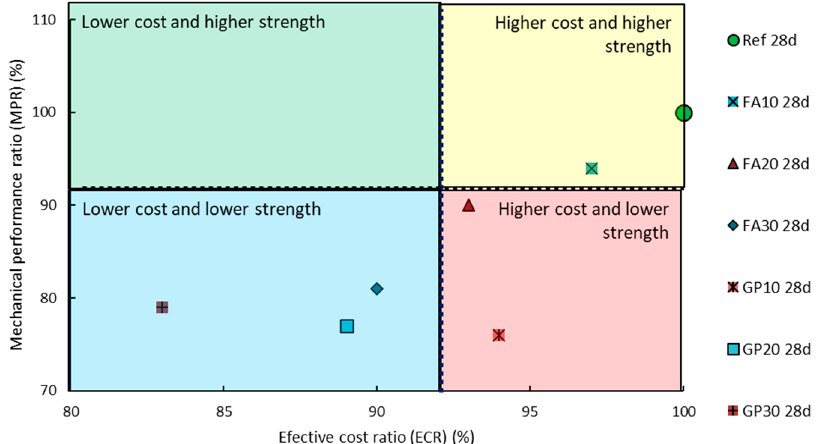
Figure 19. Mechanical performance ratio ( MPR ) and effective cost ratio ( ECR ) values after 28 days with regards to the series of the air-cured hardened cementitious mortars.